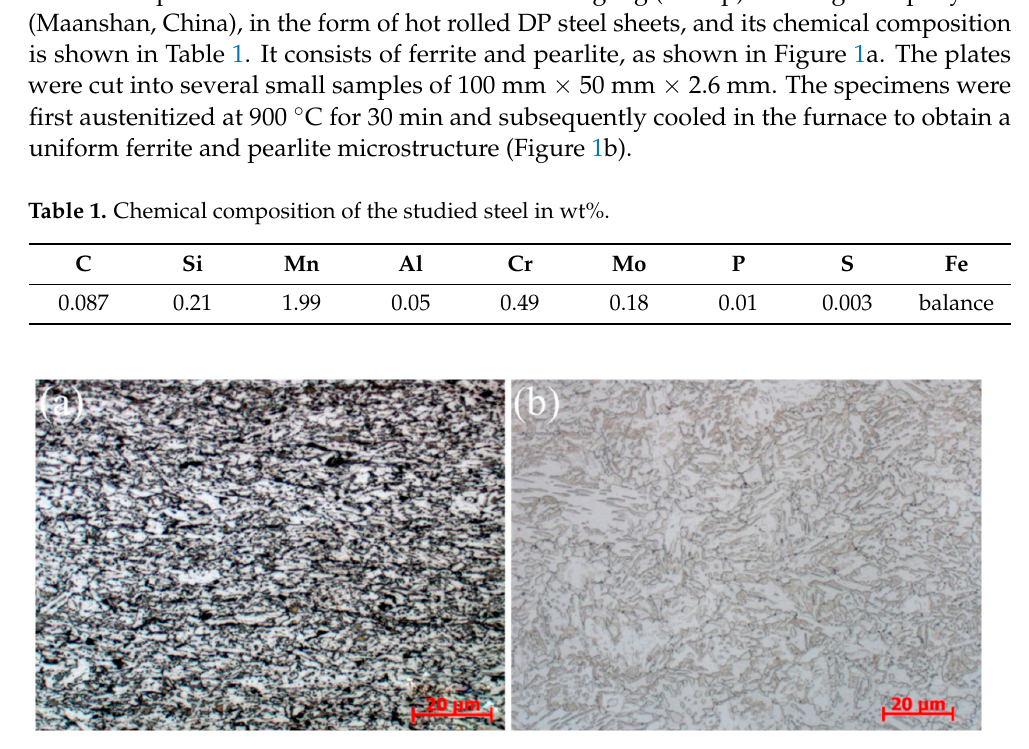
Table 1. Chemical composition of the studied steel in wt%.